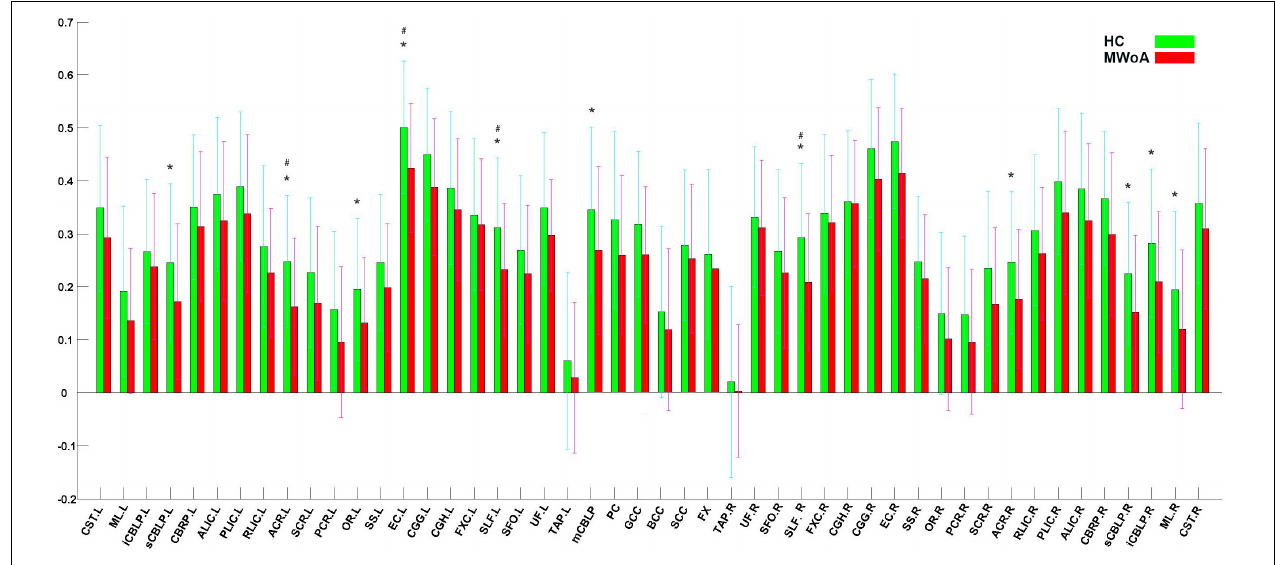
FIGURE 2 | Quantitative comparisons between patients with MWoA and HCs in GM-averaged correlation coefficients of each bundle. The asterisks (*) denote p < N/1(0. 0.012195). The ( # ) denote p (FDR adjusted) < 0.05.